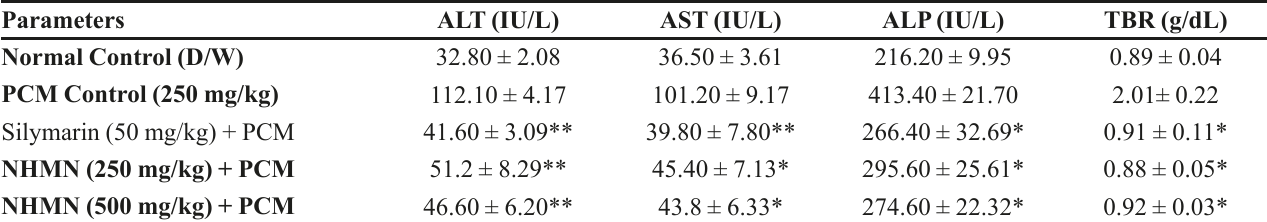
TABLE III - Effect of n -hexane extract of Morus nigra (NHMN) on liver enzymes and total bilirubin